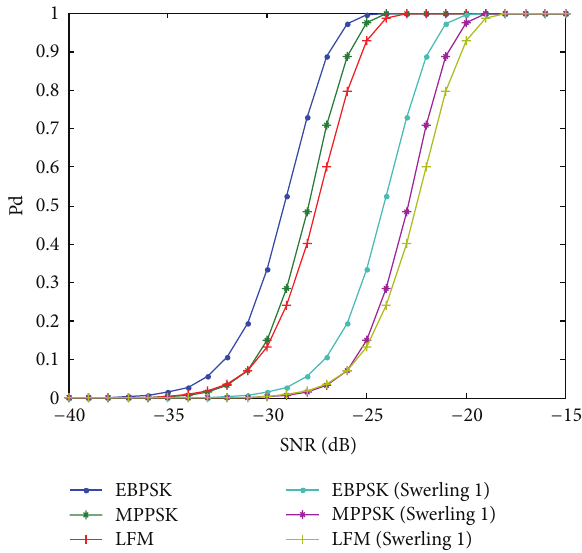
Figure 6: CFAR target detection probability comparisons for V = 2000 m/s.